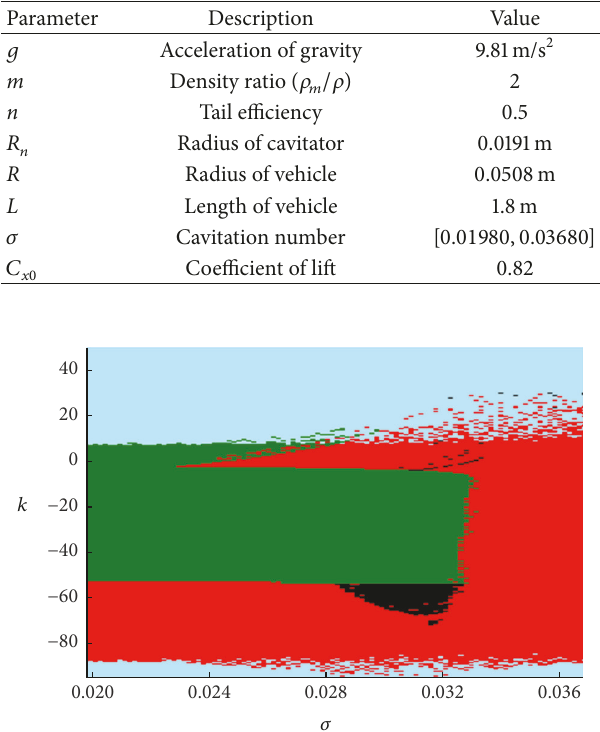
Figure 3: Distribution diagram of dynamic behaviors of supercavi- tating